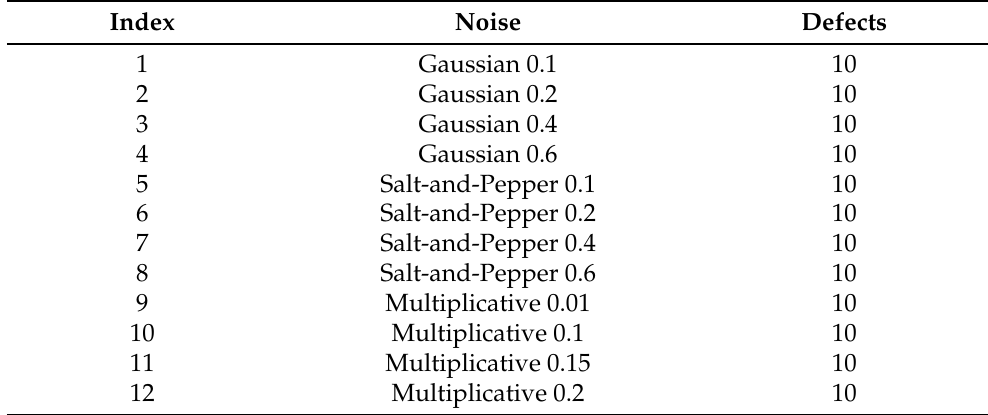
Table 1. Simulated datasets with different